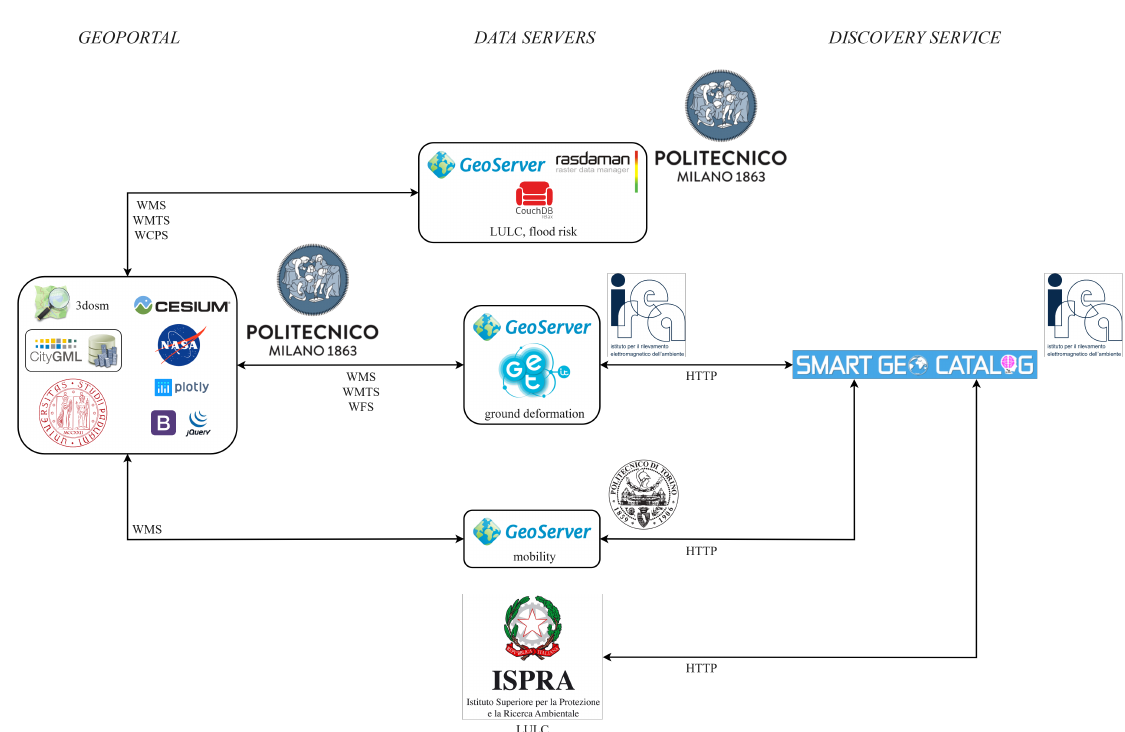
Figure 1. Software architecture of the URBAN GEOmatics for Bulk Information Generation, Data Assessment and Technology Awareness (URBAN GEO BIG DATA) project that is composed of a geoportal for geospatial data visualization, query and processing, a discovery service for enabling the search of geospatial data based on various parameters and data servers that host the geospatial data used by the geoportal and the discovery